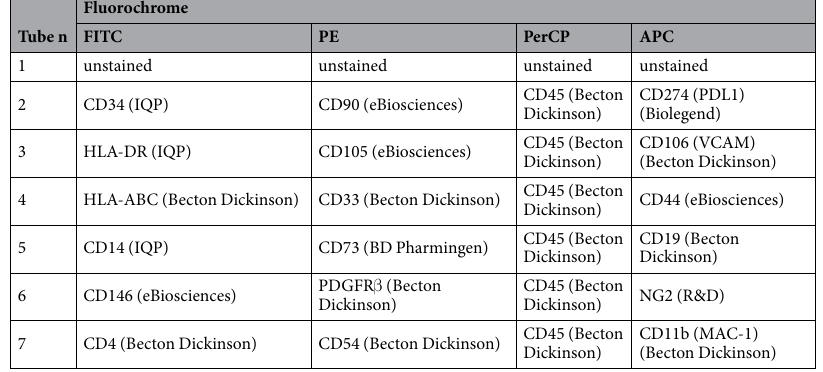
Table 2. Combinations of fluorochrome-conjugated monoclonal antibodies used for the immununophenotypic characterization of